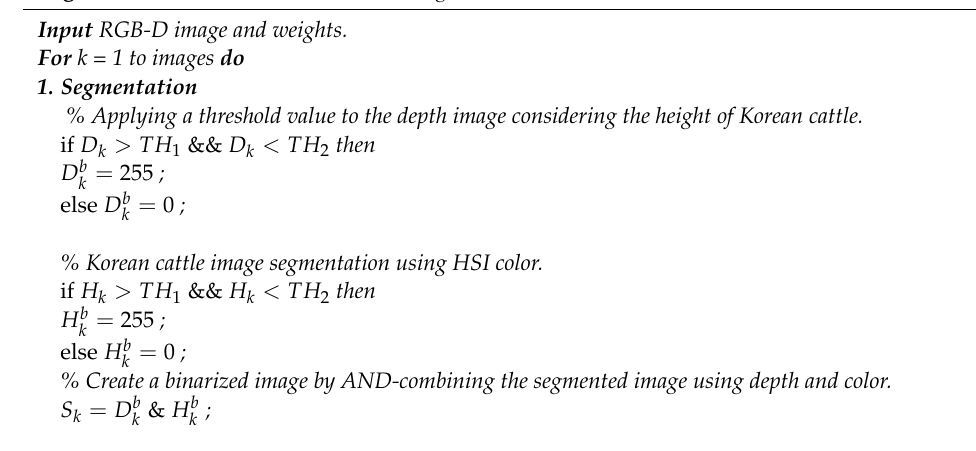
Algorithm 1: Procedure Korean Cattle Weight